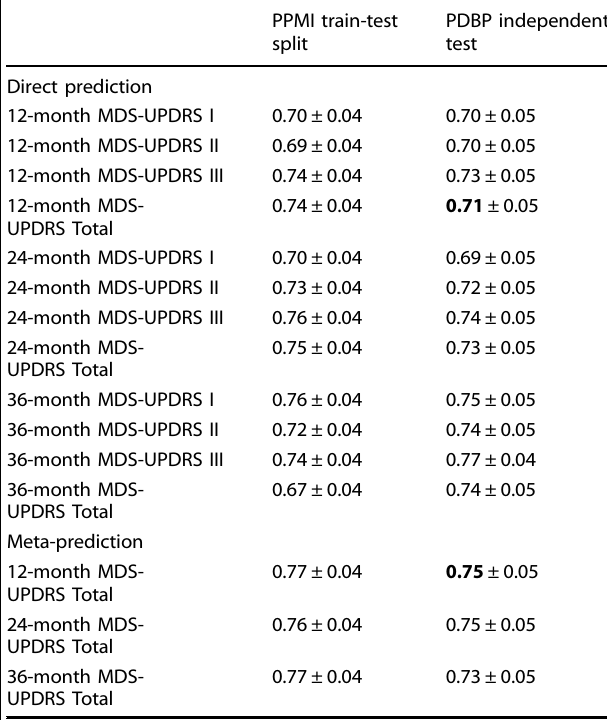
Table 3. Accuracy of direct and meta-prediction of MDS-UPDRS I, II, III, and total progression.